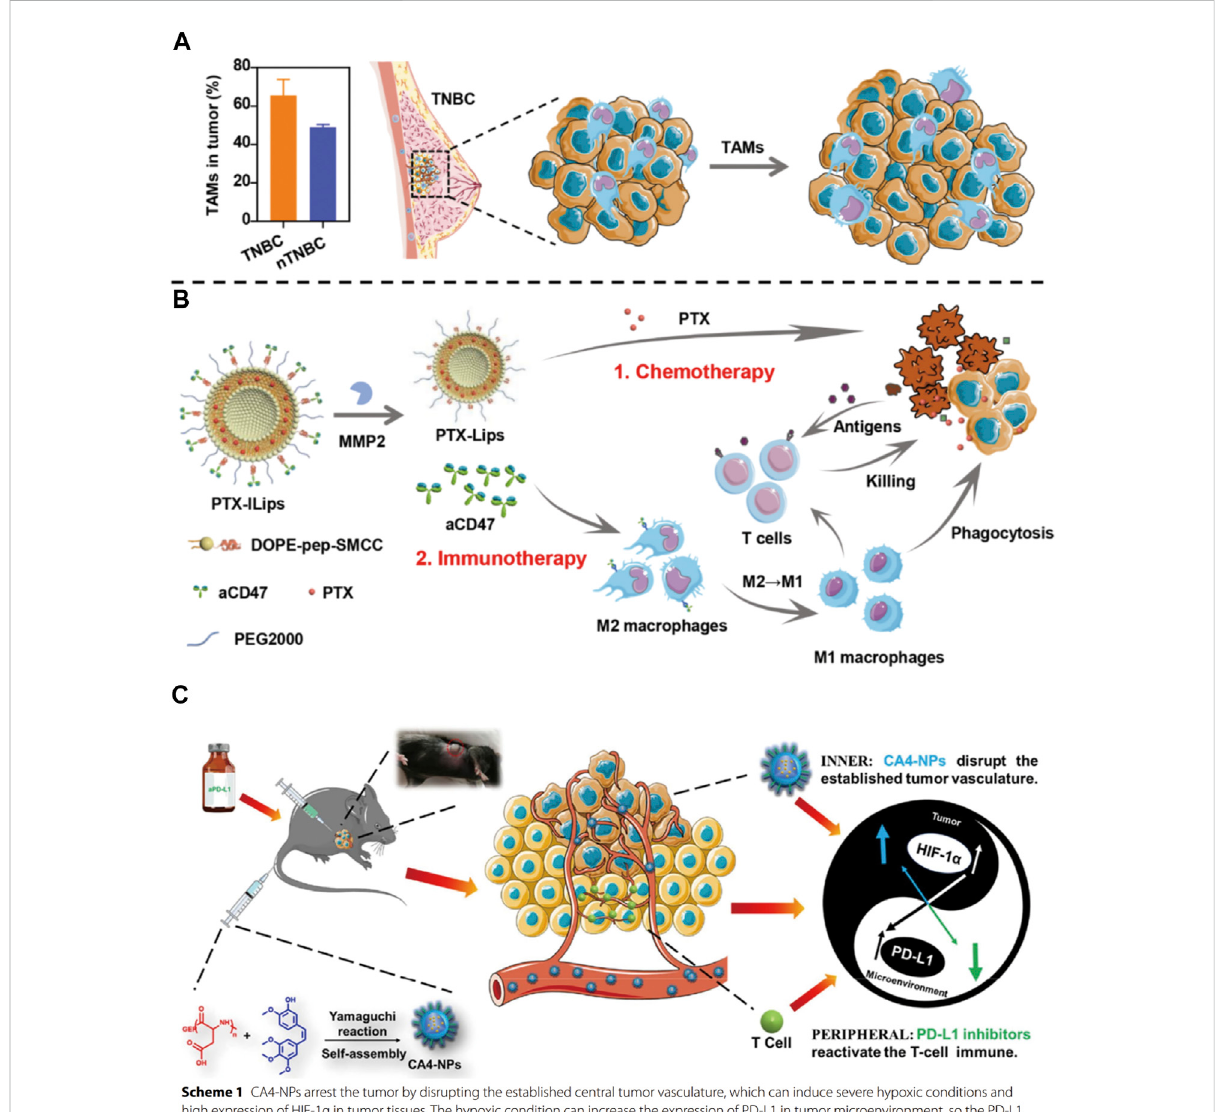
FIGURE 6 (A) Tumor-associated macrophages (TAMs) promote tumor growth in triple-negative breast cancer (TNBC) and (B) PTX-ILips designed for the enhanced ef fi cacy of immunochemotherapy against TNBC (Chen et al., 2021). (C) Mechanism of action of thecombination of CA4-NPs and aPD-L1 (Zhao et al.,